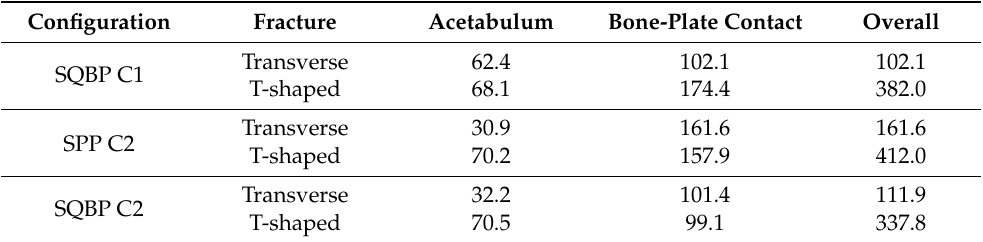
Table 6. Maximum Von Mises stress (expressed in MPa) reached in the acetabular region, at the bone-plate contact and in the whole model.